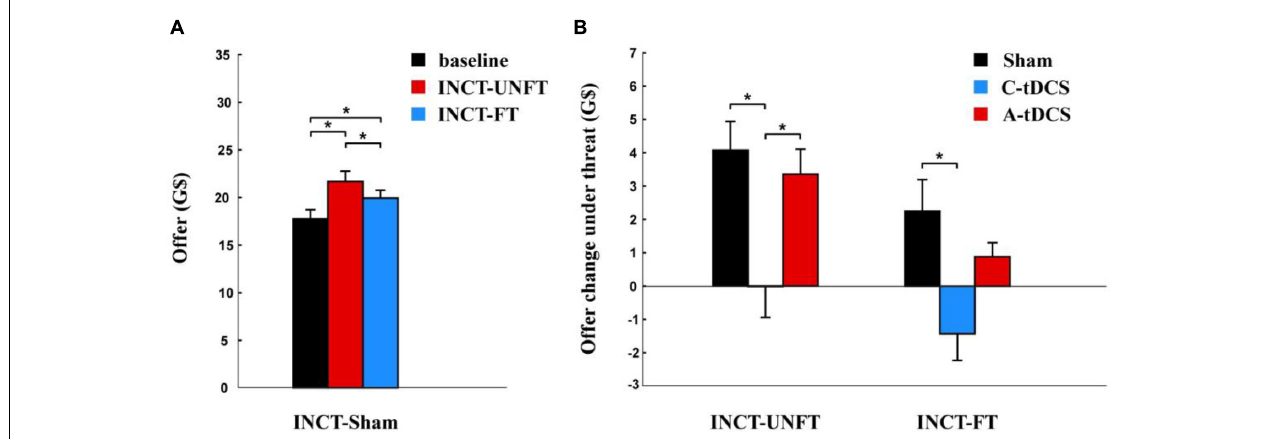
FIGURE 2 | Offer change after incredible threat. (A) Mean offer amount to the partner and the standard error in sham group. (B) Effects of tDCS and fairness on the offer change and the standard error in cathodal (C-tDCS), anodal (A-tDCS), and sham stimulation group for each fairness level. The interaction between fairness and stimulation was not significant. ∗ p <